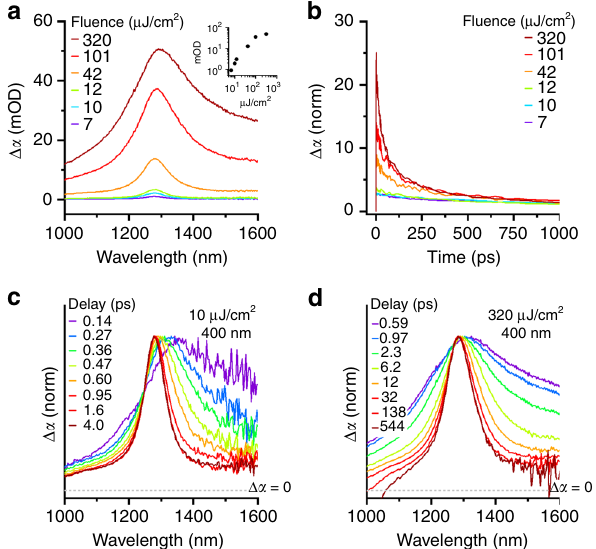
Fig. 5 Auger and hot-carrier effects on intersubband absorption. a Transient absorption spectra of 5.5 ML CQW pumped at 400nm at 2 ps delay for several indicated fl uences. The inset data show the peak change in optical density of the photoinduced absorption vs. fl uence. b Dynamics of 5.5 ML CQW-induced absorption feature at several fl uences. Data are normalized by the average signal between 1500 and 2000ps. c , d Transient absorption spectra of a 5.5 ML CQW sample pumped with 400 nm photons at c 10 μ J/cm 2 and ( d ) 320 μ J/cm 2 for several indicated delay times